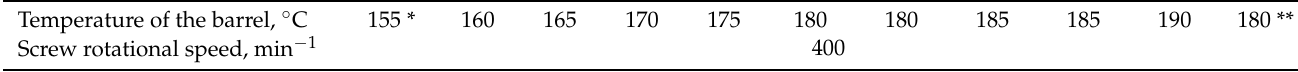
Table 2. Process settings for the in-house production of different formulations on the twin screw extruder. Temperature of the barrel, ◦ C 155 *